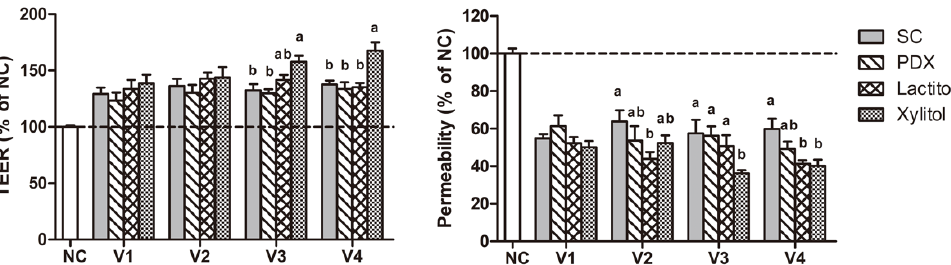
Figure 3. Effect of fermentation products on the epithelial barrier function. HT29-MTX-E12 cells were pre-treated with deoxynivalenol, and then 5% fermentation products of simulation control (SC), polydextrose (PDX), lactitol and xylitol were added. Transepithelial electrical resistance (TEER) and paracellular permeability data were obtained from four independent cell assays with duplicates (n = 8), and presented as mean values ± SEM, relative to negative control (NC = 100%). NC indicates growth medium without FCS and fermentation products. V1–V4 indicates vessel 1 to vessel 4 in in vitro EnteroMix fermentation model. All fermentation products differed significantly with NC ( p < 0.001), and only differences between fermentation products are shown in the figure. Different lowercase letters indicate significant differences between four fermentation products within each vessel at p < 0.05 according to Tukey’s test.